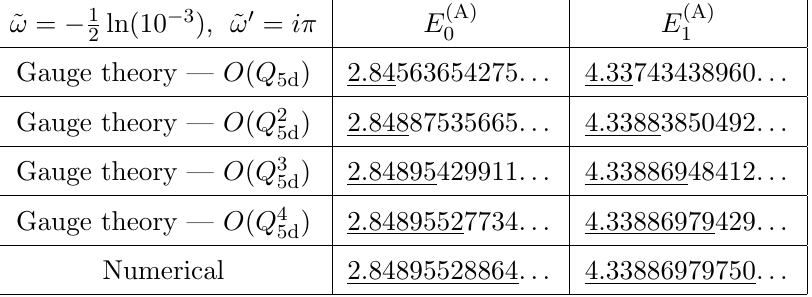
Table 9 . Gauge theory energies for the 2-eRS A model (3.12) at g y = 2, ~ y = 1 obtained from the na(cid:127)(cid:16)ve WKB quantization conditions (3.65).